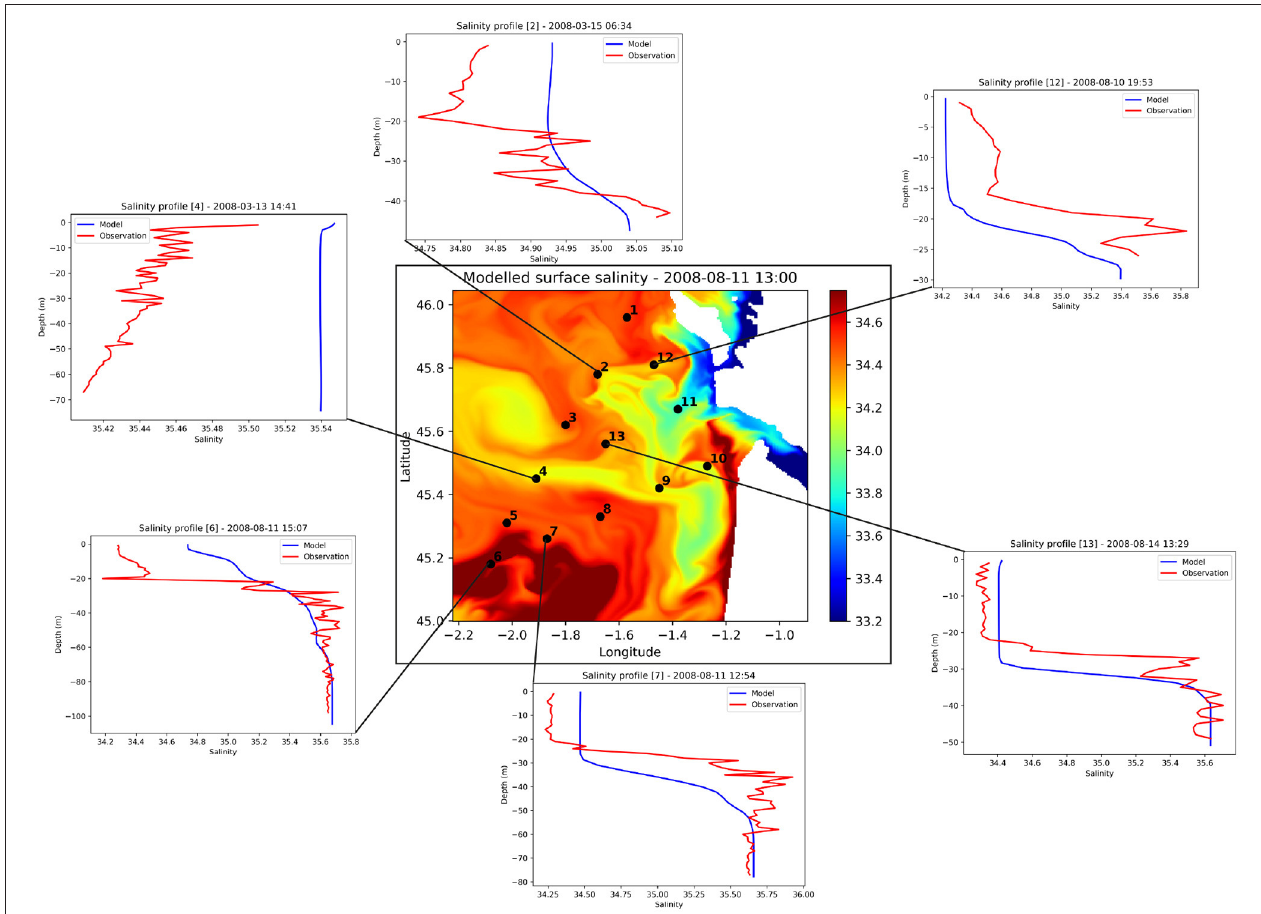
FIGURE 6 | Map of the simulated surface salinity for the 11th August 2008 including station positions of ECLAIR cruises in 2008. Example of associated individual salinity profiles (blue—modeled, red—observed) in March (stations 2 and 4) and in August (stations 6, 7, 12, and